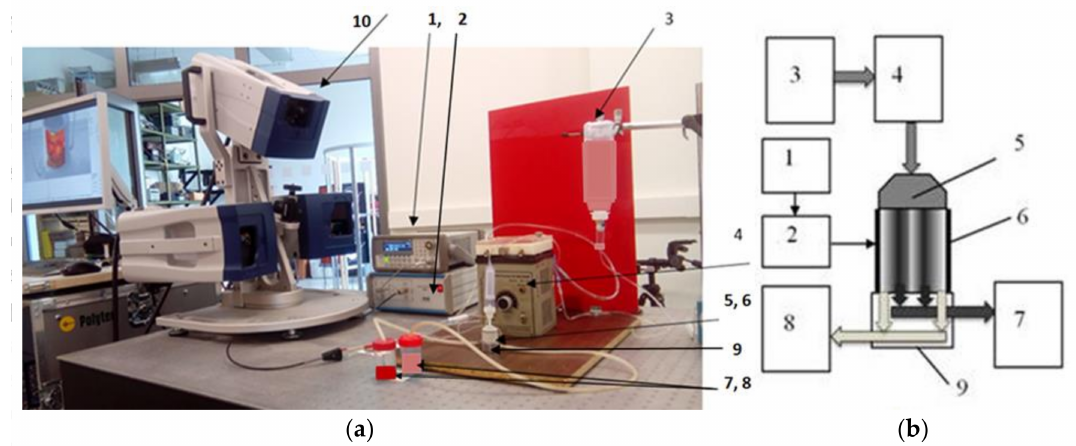
Figure 1. Photo of the experimental setup ( a ) and block diagram ( b ) for the separation of microparticles suspended in a fluid: ultrasonic frequency signal generator (Agilent 33220A) (1), voltage amplifier P200 (FLC Electronics) (2), container of the fluid (3), peristaltic pump (Model NP-1M) (4), inlet of the actuator (5), piezoelectric tube-shaped actuator (6), containers for the microparticles phase and the fluid phase (7 and 8), collector of the fluid (9) and Polytec 3D scanner-vibrometer